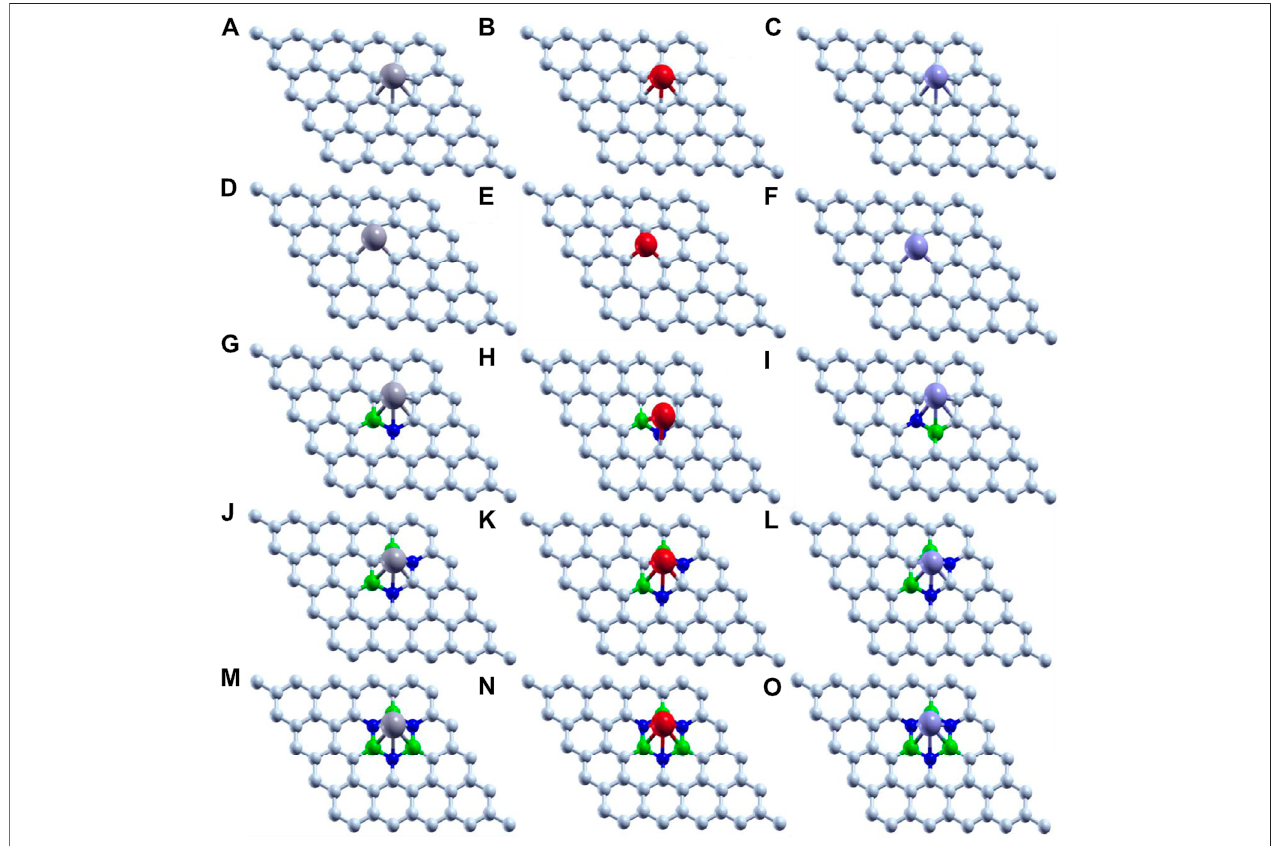
FIGURE 2 | Optimized structure of adsorption of Mo (gray), Fe (red), and V (purple) on (A – C) pristine graphene, (D – F) defective graphene, (G – I) BN-doped graphene, (J – L) BNC-ring graphene, and (M – O) BN-ring graphene.